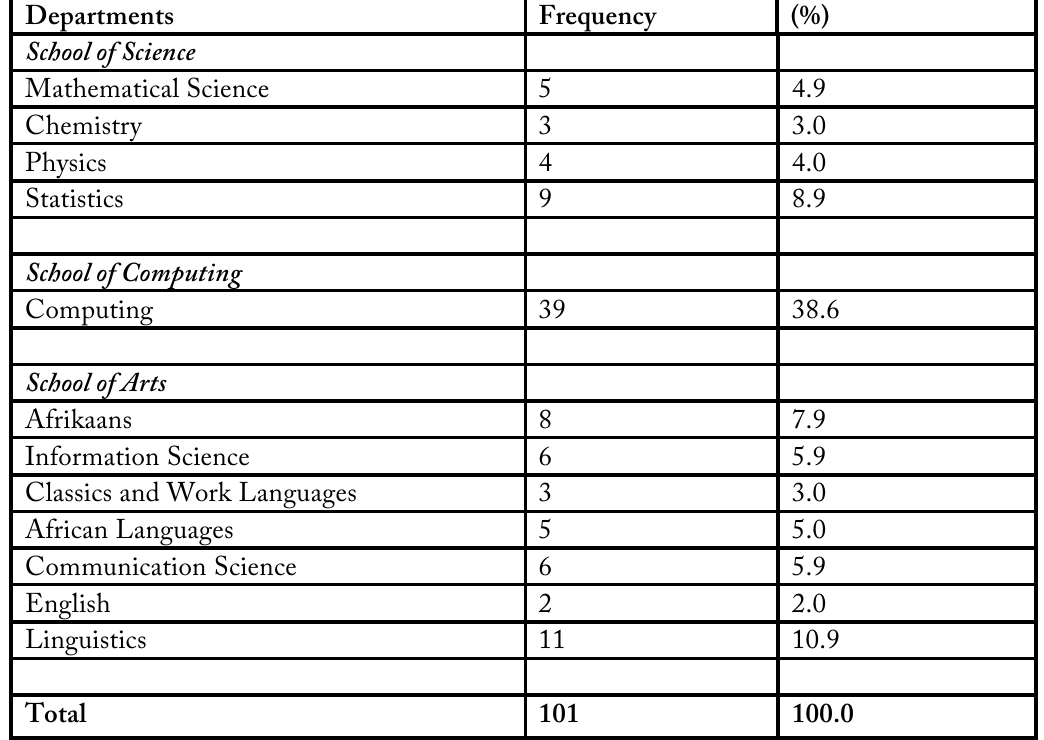
Table 2: Distribution of respondents per department in the Schools (N = 101)